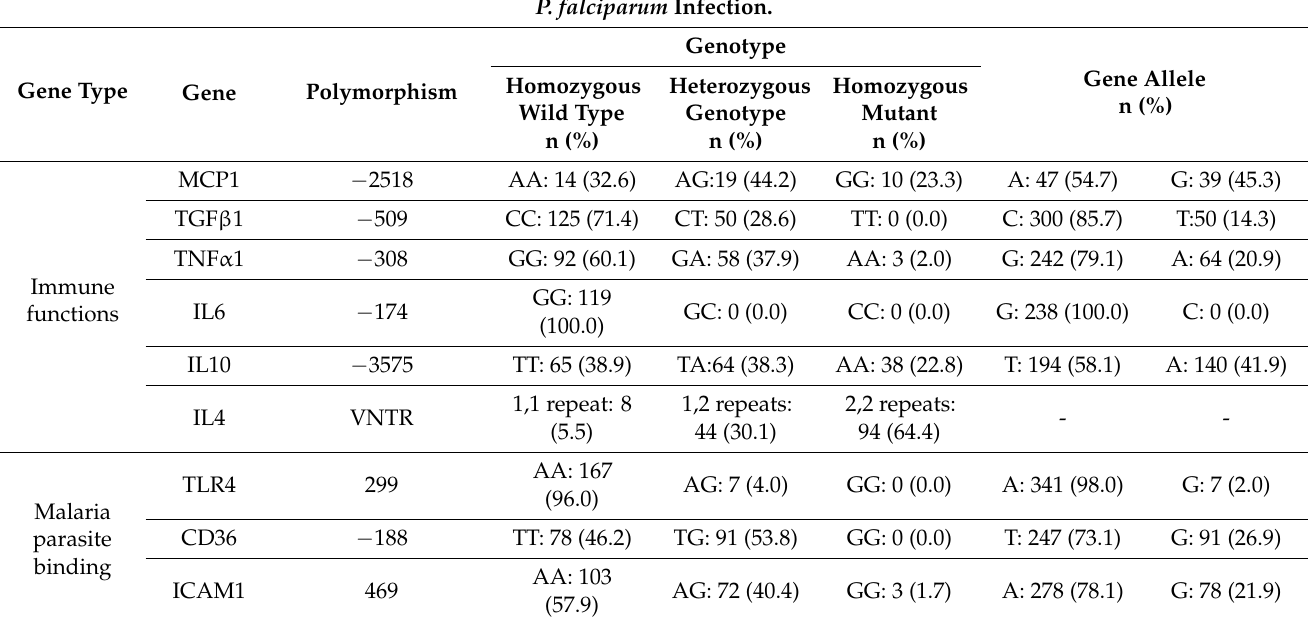
Table 3. Distribution of genotypes and gene alleles of host genes related to malaria severity. Data are presented as number (%) or median (range)